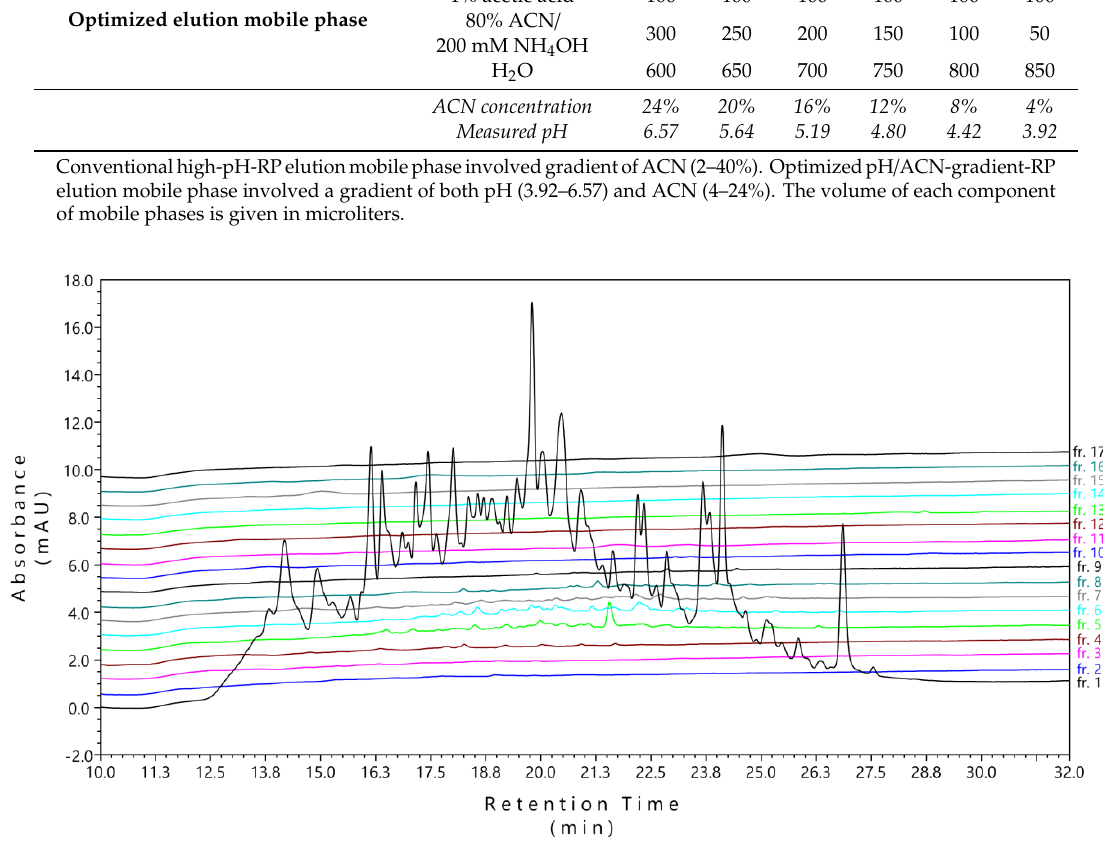
Figure 2. LC – UV chromatograms of the fractionated TiO 2 -enriched phosphopeptide sample obtained from trypsin-digested H1299 cell lysate. The fractionation was performed using the conventional reversed-phase microgradient separation with the acetonitrile (ACN) gradient under basic pH conditions. The first fraction was the flow-through of the TiO 2 -enriched phosphopeptides dissolved in loading buffer of 2% ACN/20 mM ammonium formate (pH 10), and fractions 2 – 17 were eluted from the microcolumn using the manually formed ACN gradient containing 20 mM ammonium formate buffered at pH 10 (see Table 1 for a detailed composition of the mobile phase used for phosphopeptide fractionation in conventional elution scheme).